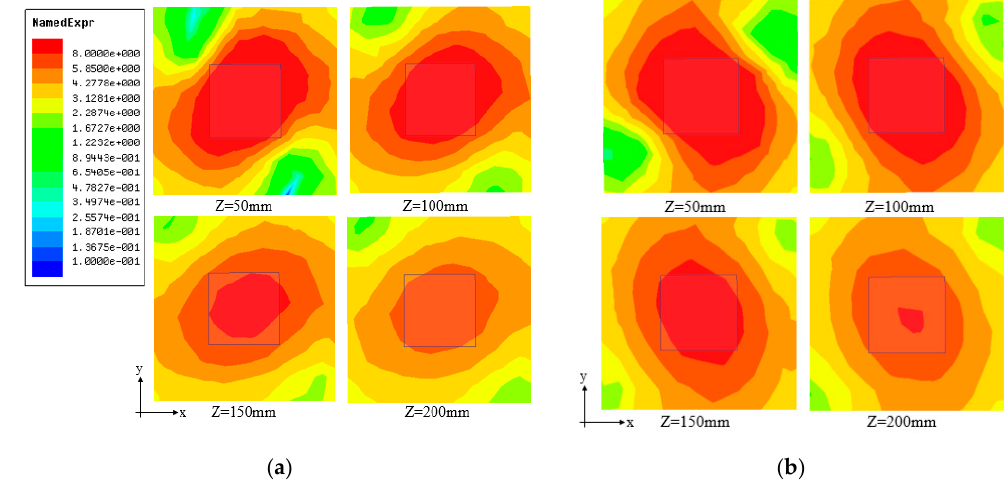
Figure 12. Distribution of simulated electric field components (Ex, Ey) at different heights with five spiral loops: ( a ) Ex distribution and ( b ) Ey distribution.